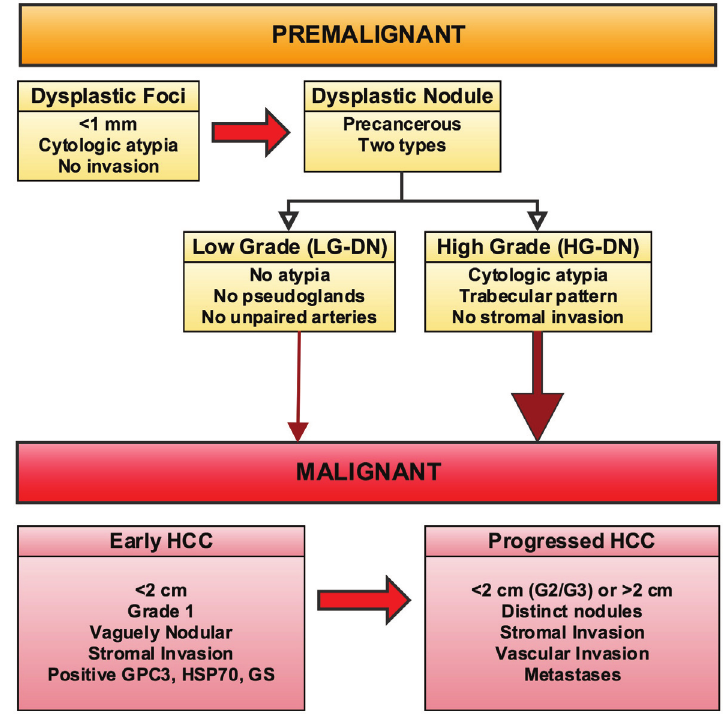
Figure 1. Natural history of precancerous lesions. Dysplastic foci (<1 mm) or dysplastic nodules (DNs) ( ≥ 1 mm) are considered precancerous lesions and are classified into low and high grade. Both low- and high-grade nodules have the potential to evolve into HCC, but high-grade DN have a much greater risk. Early HCCs are characterized by the presence of stromal invasion. HCC is further subclassified into early HCC and progressed HCC based on features noted in the figure. Abbreviations: HCC, hepatocellular carcinoma; HG-DN, high-grade dysplastic nodule; LG-DN, low-grade dysplastic